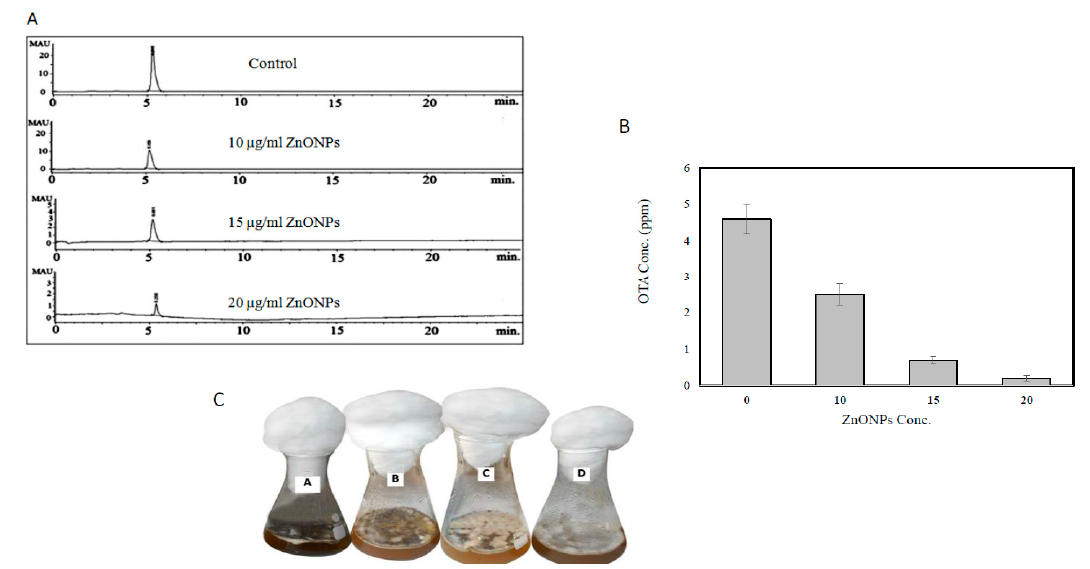
Figure 6. ( A ) HPLC chromatogram of Ochratoxin A from A. awamori after treatment with 0, 10, 15, 20 µg of ZnONPs/mL. ( B ) Ochratoxin A yield from A. awamori in response to different doses of ZnONPs. ( C ), Visual observation of broth cultures of A. awamori JQ695830.1 in response to different doses of ZnONPs.